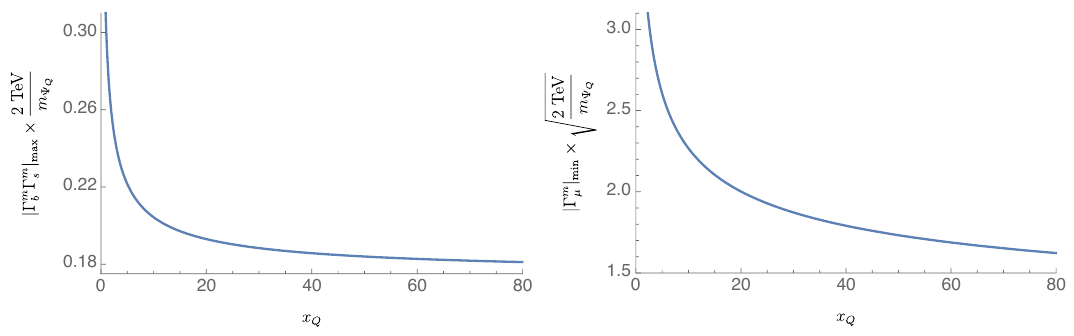
Figure 3 . Comparison of the upper bound, for the simple single scalar model introduced in section 2, on j (cid:0) m (cid:0) m j from B s (cid:0) (cid:22) B s mixing (left panel) with the lower bound on j (cid:0) m s b for x ‘ = 1 (right panel), as a function of x Q